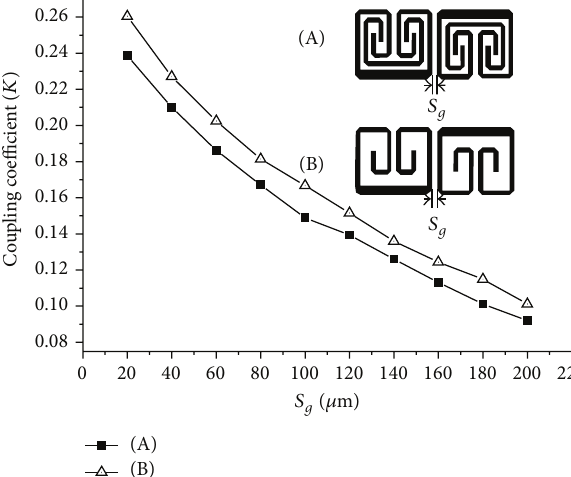
Figure 3: The coupling coefficient as a function of the spacing 𝑆 𝑔 between the resonators, (A) the stub-load meander-line and (B) without the stub-loaded